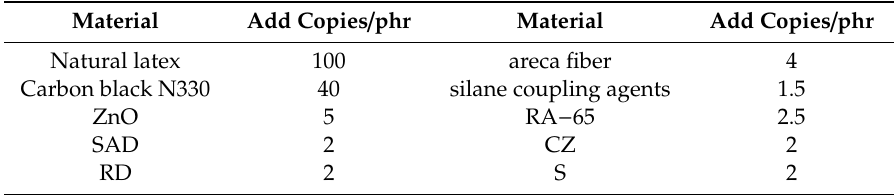
Table 1. The experimental formula.